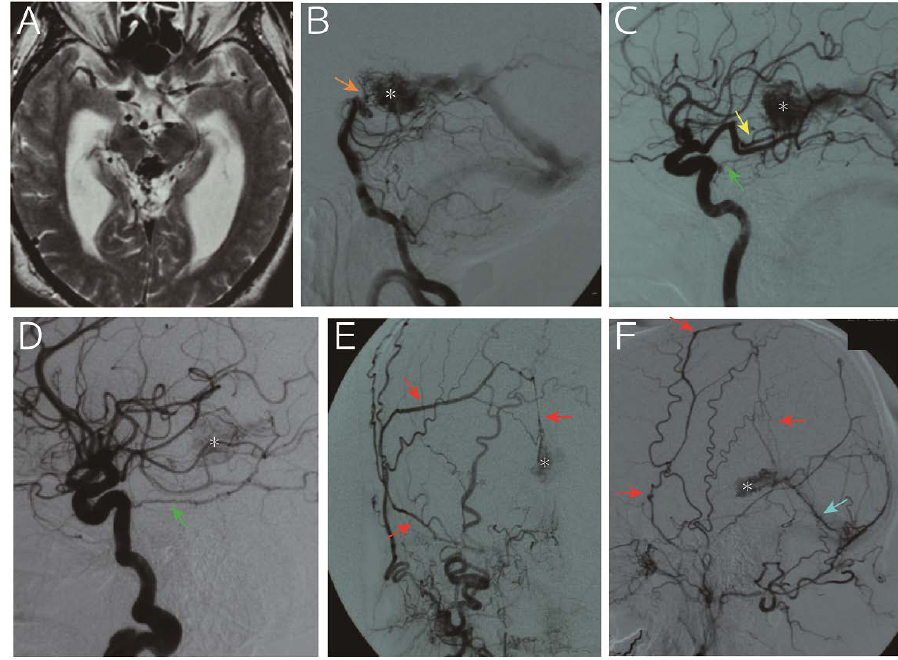
Figure 3. A 65-year-old man was referred to us for progressive headache and gait disturbance.